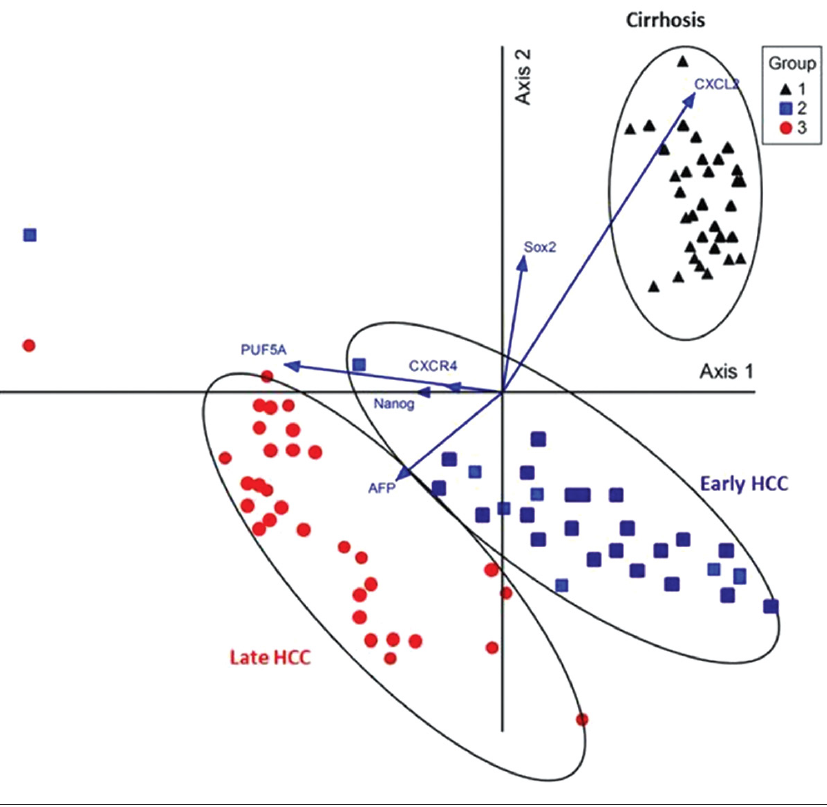
Figure 3. Multivariate analysis by nonmetric multidimensional scaling (NMS) ordination analysis in patients. NMS joint plot showing the separation of three distinct groups of patients along axes 1 and 2 based upon the data collected from gene expression. Dif- ferent genes’ direction and power of correlation with axis 1 and 2 are demonstrated. Both CXCL2 and AFP might be considered as potential genes responsible for the groups’ separation. CXCL2 increased dramatically toward the noncancer group, while much less expression was shown in cancer patients. AFP increased dramatically toward the patients with late hepatic carcinoma and much less expression was shown with early cancer pa-